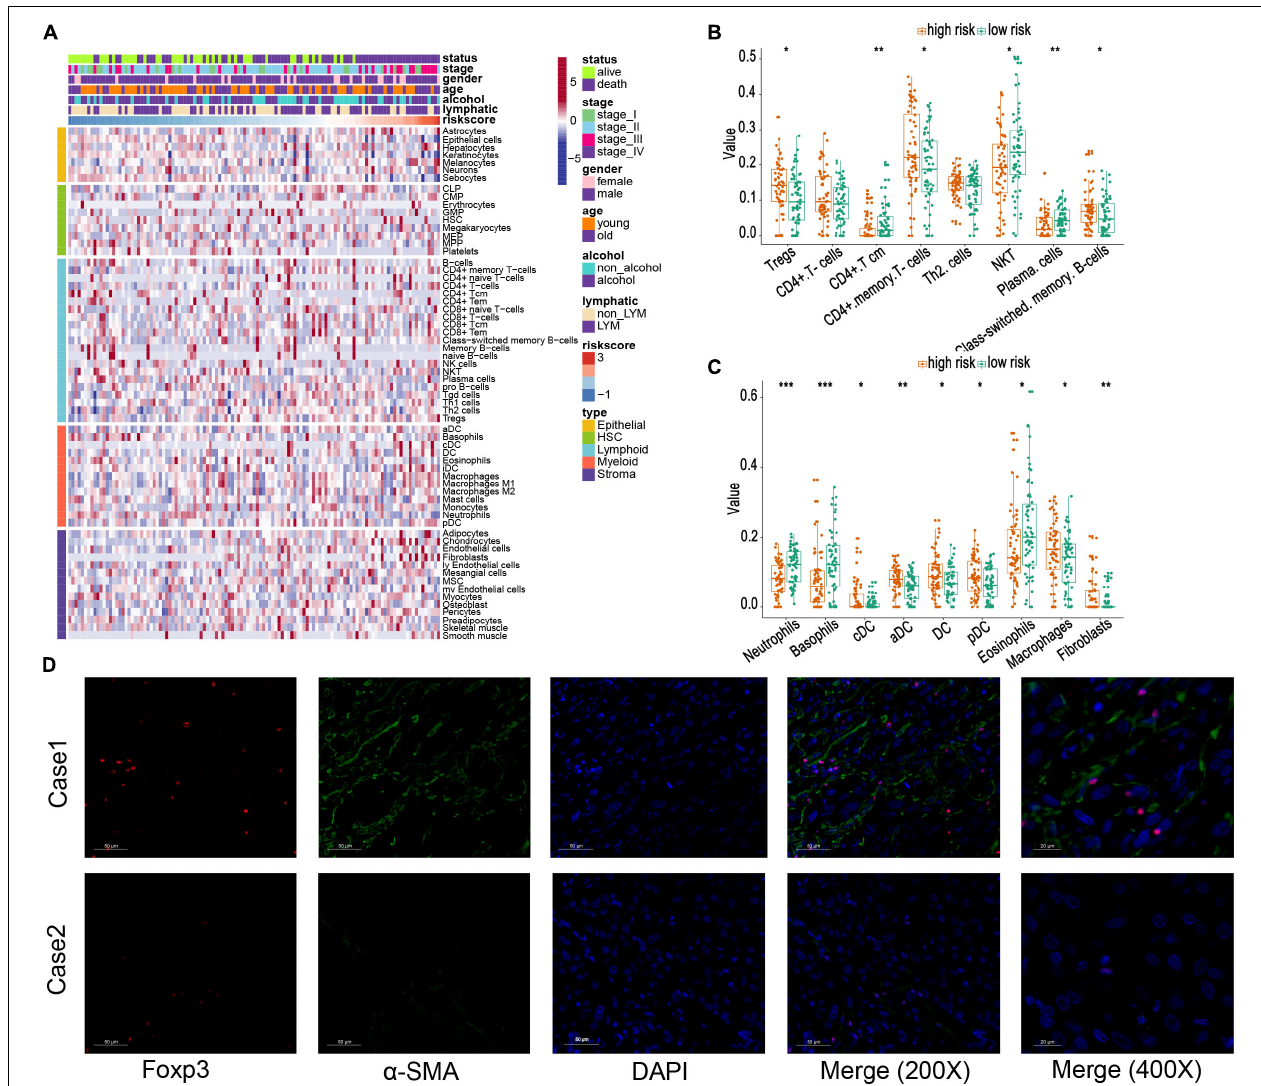
FIGURE 6 | Relationship between risk score and different cells estimated by xCell. (A) The landscape of risk score and different cell infiltration. (B,C) Different distributions of estimated cells in high- and low-risk groups. (D) Immunofluorescence images of Tregs and fibroblasts in tissues from the high-risk group (Case 1) and low-risk group (Case 2), respectively. The foxp3 is marked as red, and α -SMA is marked as green (200 × ) *, **, and *** represent P < 0.05, P < 0.01, and P < 0.001, respectively. Young and old represent age < 60 and age ≥ 60 years,